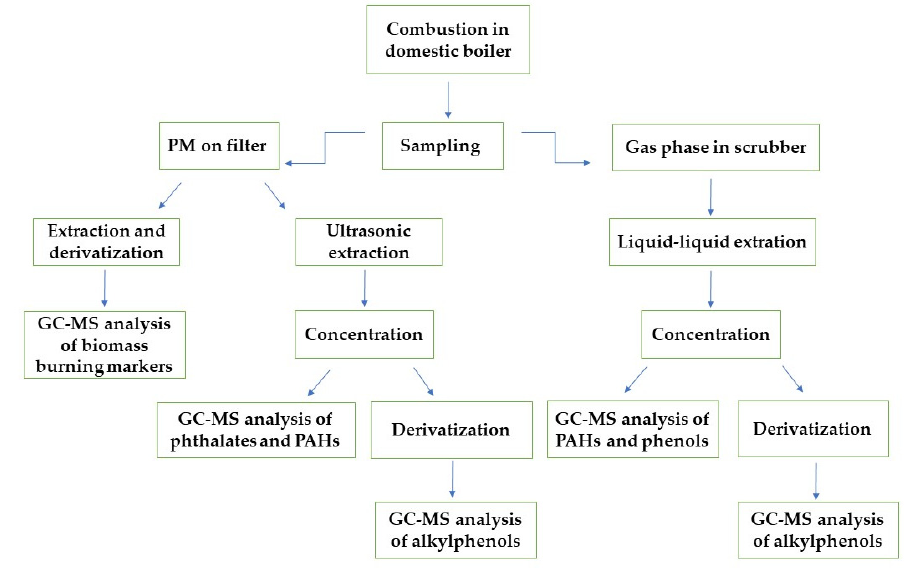
Figure 2. Samples testing procedure.